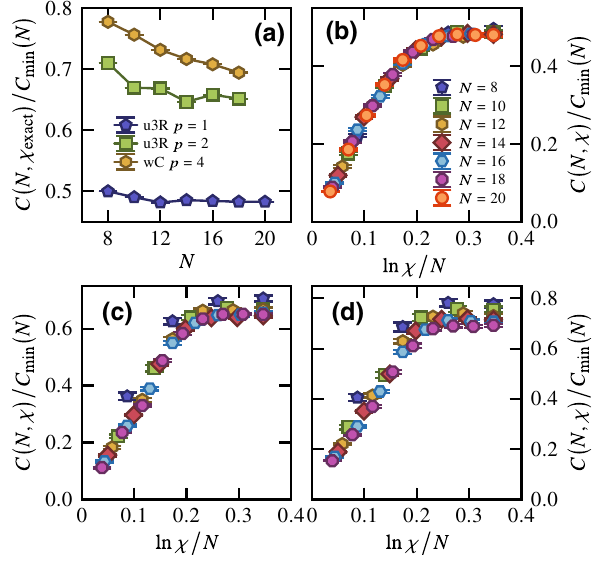
FIG. 6. (a) The approximation ratio r = C ( N , χ exact )/ C min ( N ) versus the system size N for unit-weight 3-regular graphs (u3R) with p = 1 and p = 2 and complete graphs (wC) with uniform random weights w ij ∈ [0, 1] and p = 4. (b)–(d) Data- collapse attempts according to Eq. (3), substituting C ( N , χ exact ) by C min ( N )